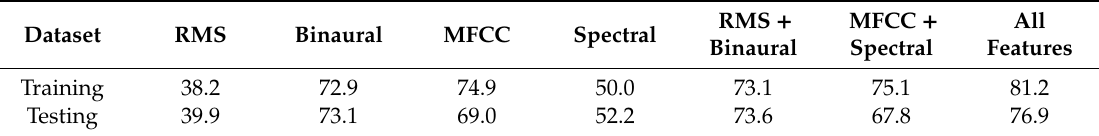
Table 4. Accuracy of classification (%) obtained upon training and testing of the model. The training and testing repository consisted of 4368 and 1560 audio excerpts, respectively.